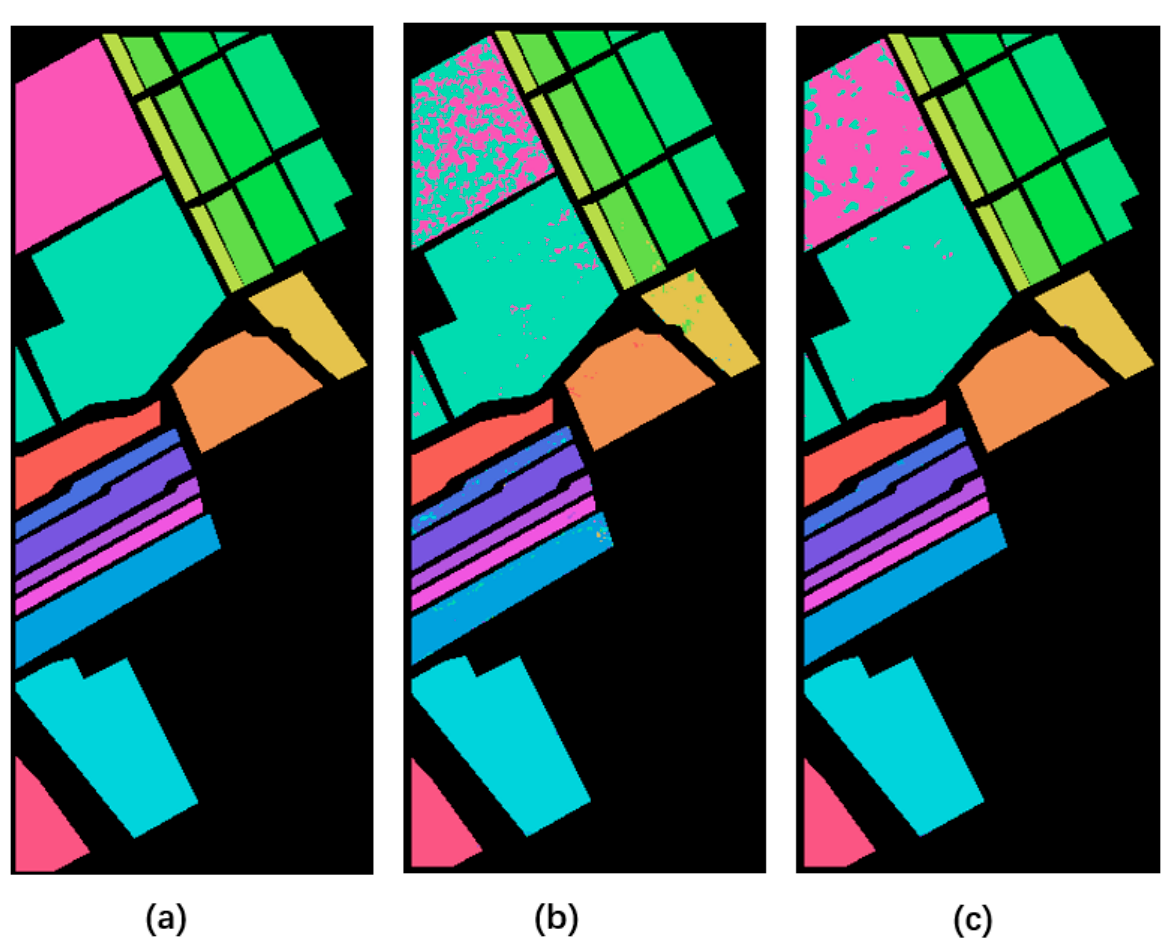
Figure 12. Classification results on the PaviaU dataset. ( a – c ) represent category labels of ground truth, classification result on degraded data, and classification result after quality enhancement, re- spectively.